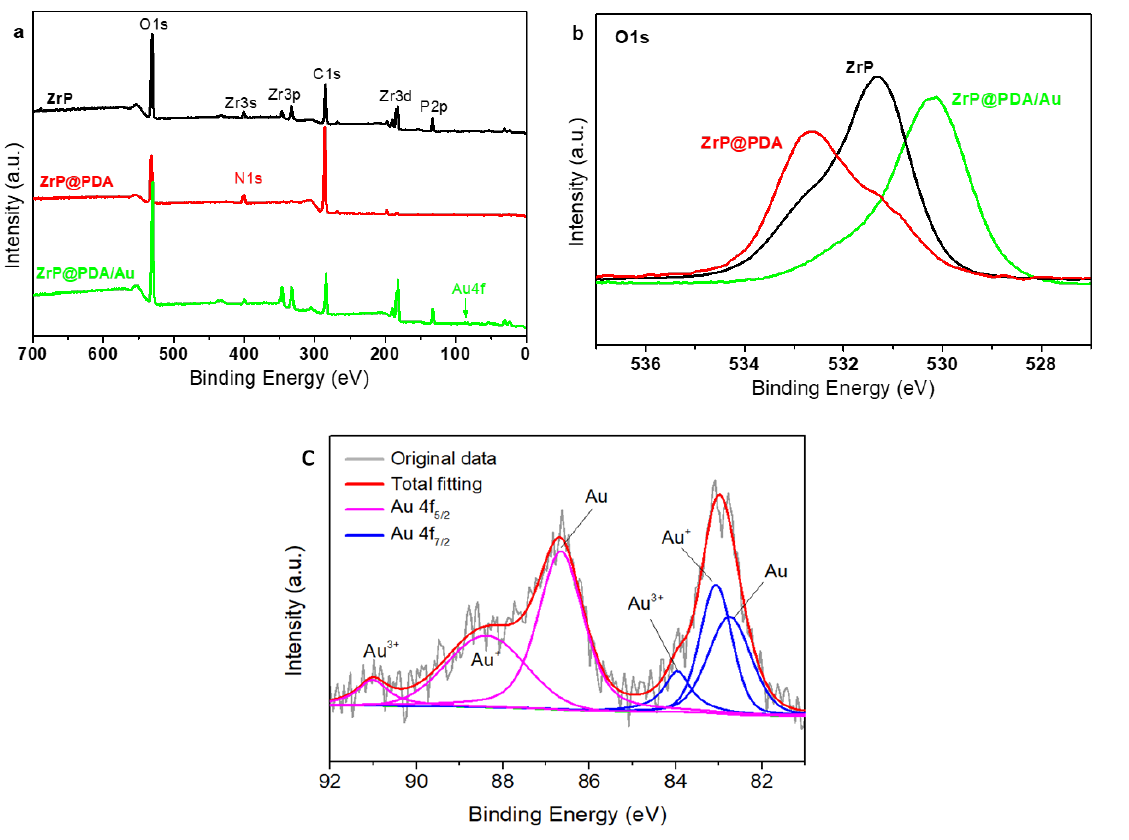
Figure 6. XPS survey ( a ) and high-resolution XPS O1s ( b ) spectra of ZrP, ZrP@PDA,